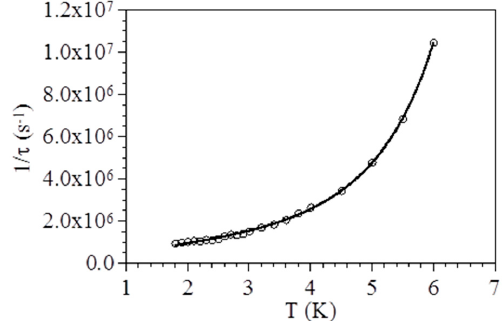
Figure 9. Inverse relaxation time (1/ τ ) of compound 1 in the temperature range 2–6 K. Solid line is the fit to Equation (5). fit to Equation